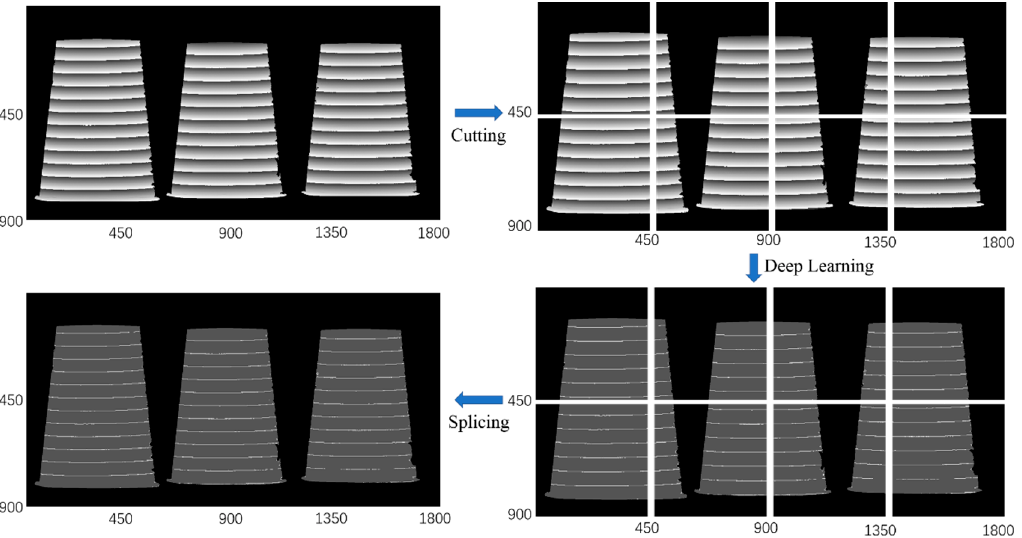
Figure 11. The workflow of phase unwrapping for large image size.